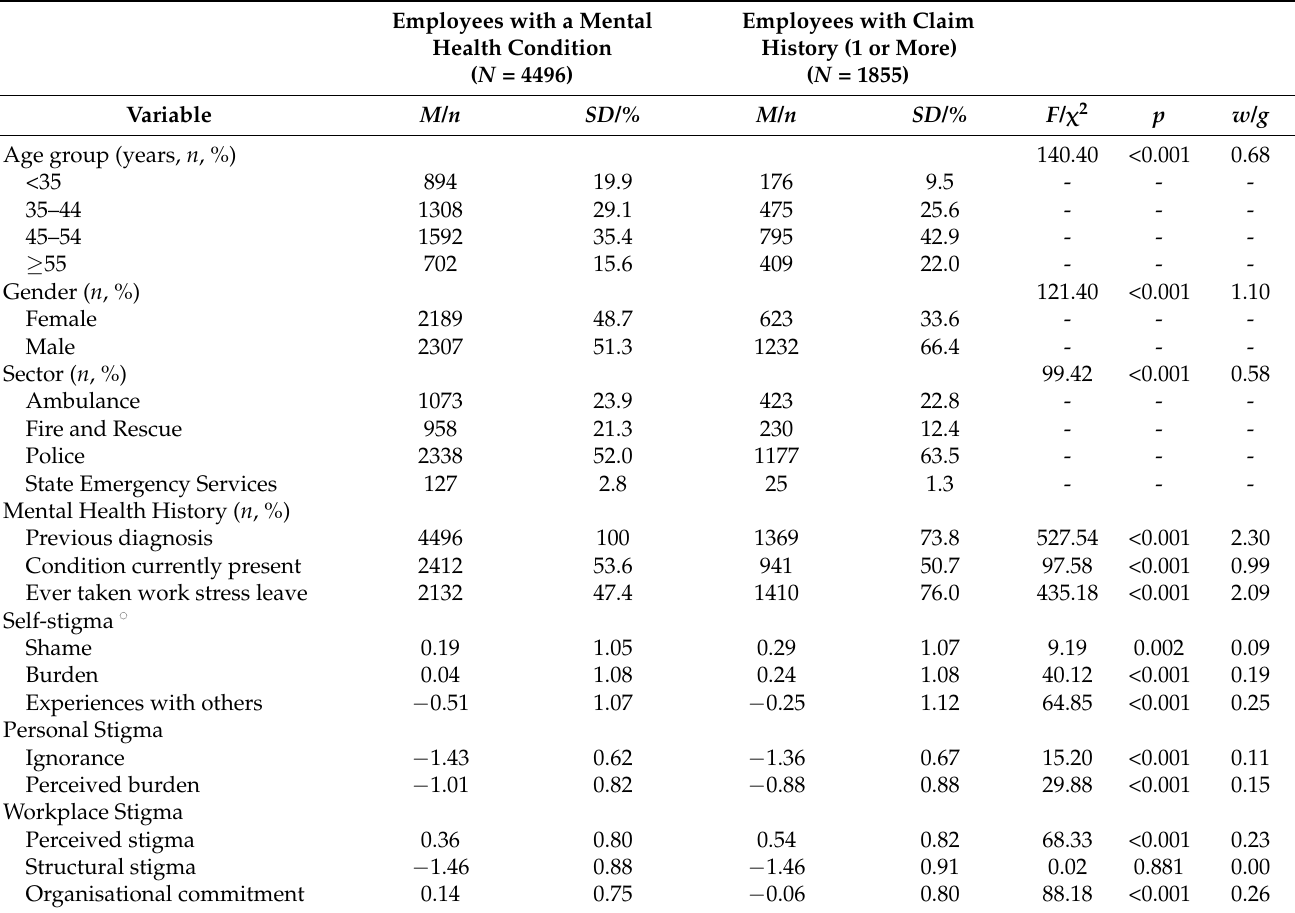
Table 2. Sample Characteristics and Between-Group Statistics on Key Variables, Comparing Employ- ees who reported Making One or More Claims with Employees who have Had a Diagnosed Mental Health Condition but Did not Make a Claim.